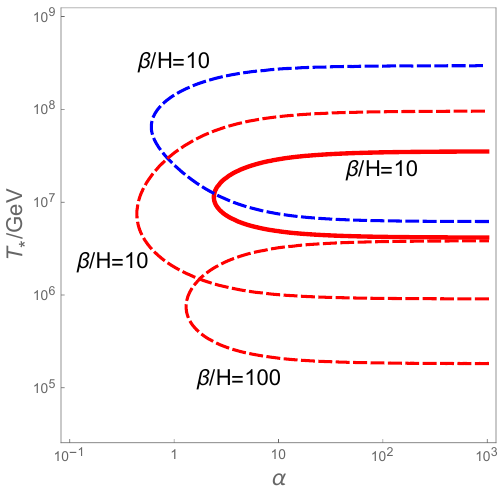
Figure 3 . Sensitivity lines for current LIGO (solid) and LIGO at design sensitivity (dashed) in the T (cid:3) (cid:0) (cid:11) plane assuming (cid:12)xed (cid:12)=H (cid:3) equal to 10 and 100 as indicated. Blue or red colors refer respectively to whether the signal is assumed of bubble wall collisions type, (2.7) with (cid:20) (cid:30) = 1 and v w = 1, or of sound waves type, (2.9) with (cid:20) sw set by (2.11) and v w = 1 = right of the curves represent detectable